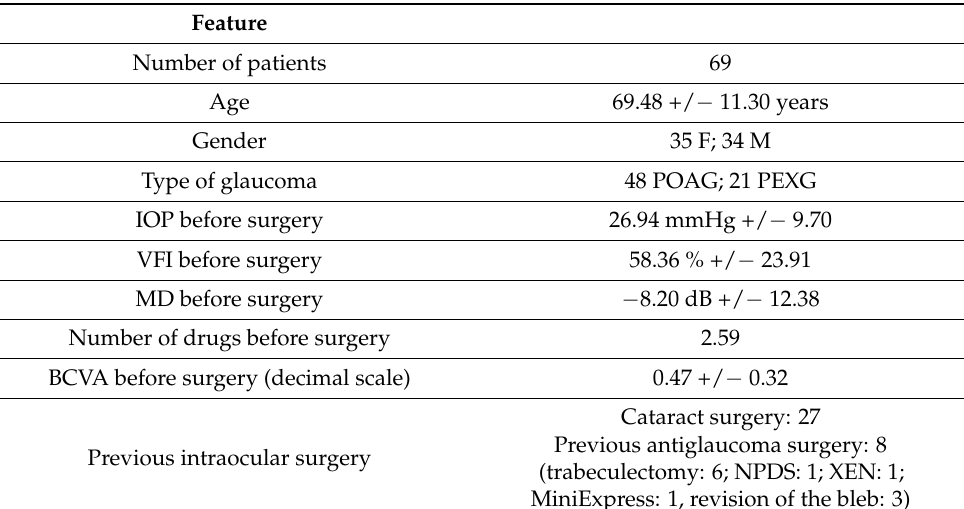
Table 1. Demographic characteristics of the studied